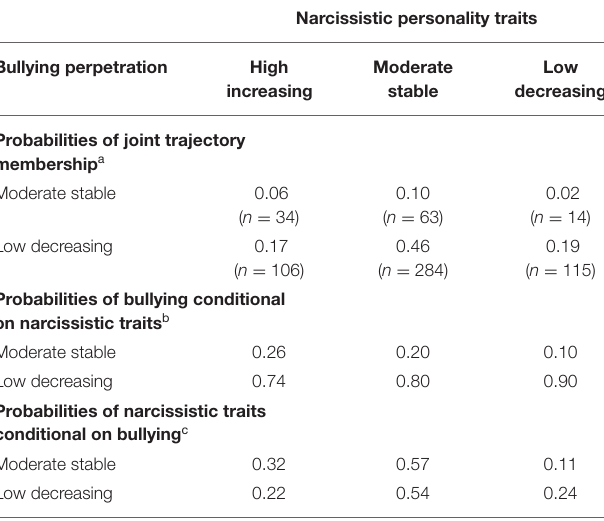
TABLE 3 | Joint and conditional probabilities of bullying perpetration and narcissistic personality